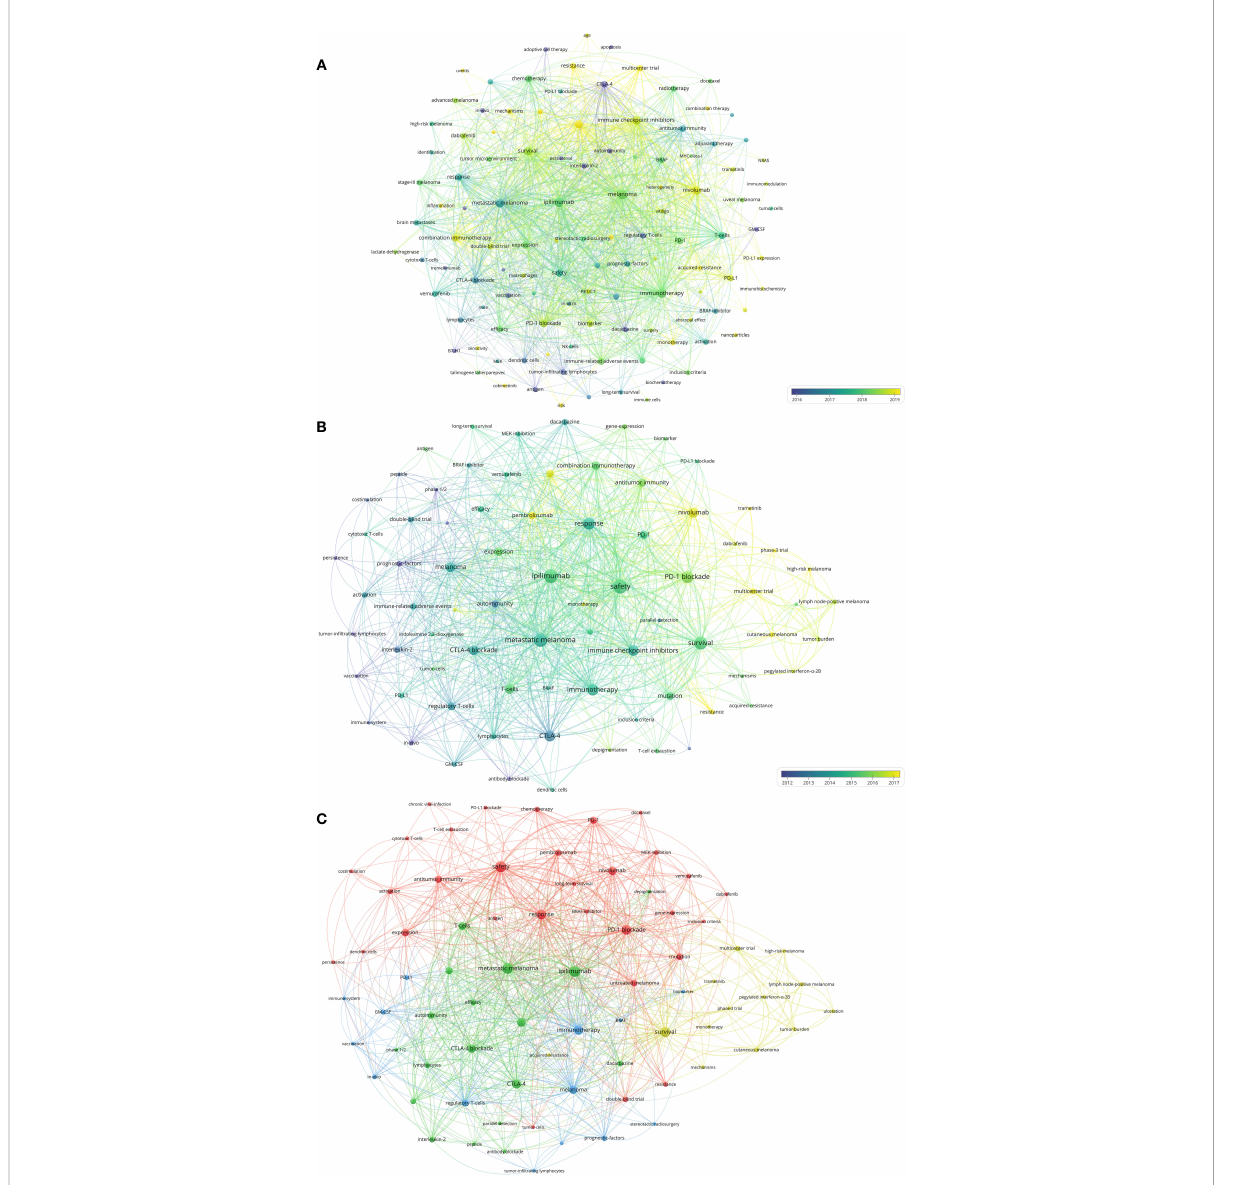
FIGURE 8 (A) Network visualization of keywords that occurred at least 10 times in the papers. (B) Network visualization of keywords that occurred at least twice in the top-papers. (C) Network visualization of keywords that occurred at least twice in papers published in major journals between 2020 and 2022. The circle size represents the number of papers. The breadth of the curves represents the connection